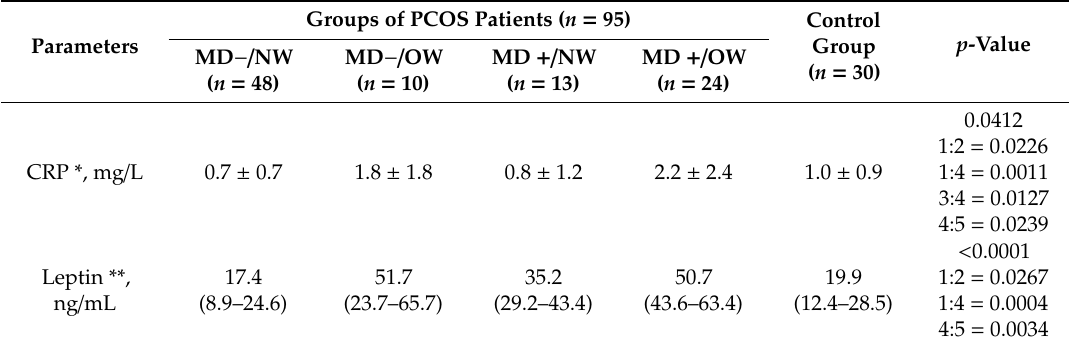
Table 2. The level of CRP and leptin in peripheral blood in adolescent girls with PCOS, grouped by BMI and presence of